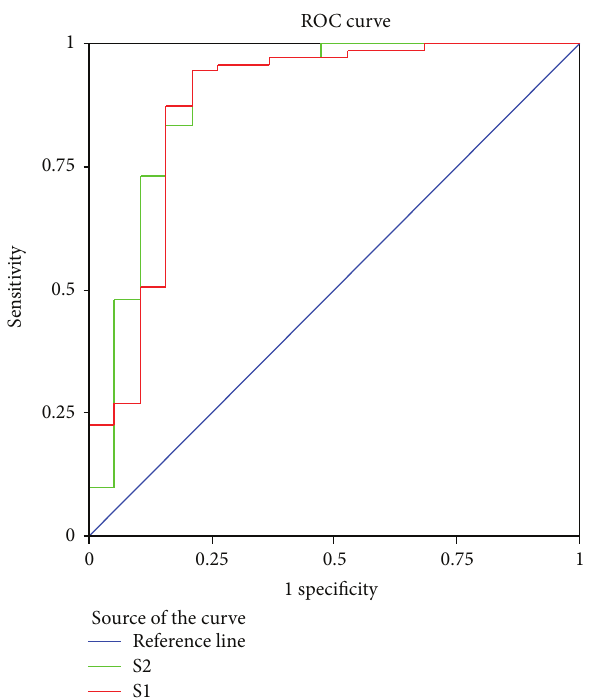
Figure 2: ROC of changes of SF-36 scores after one-week or two- week treatment.